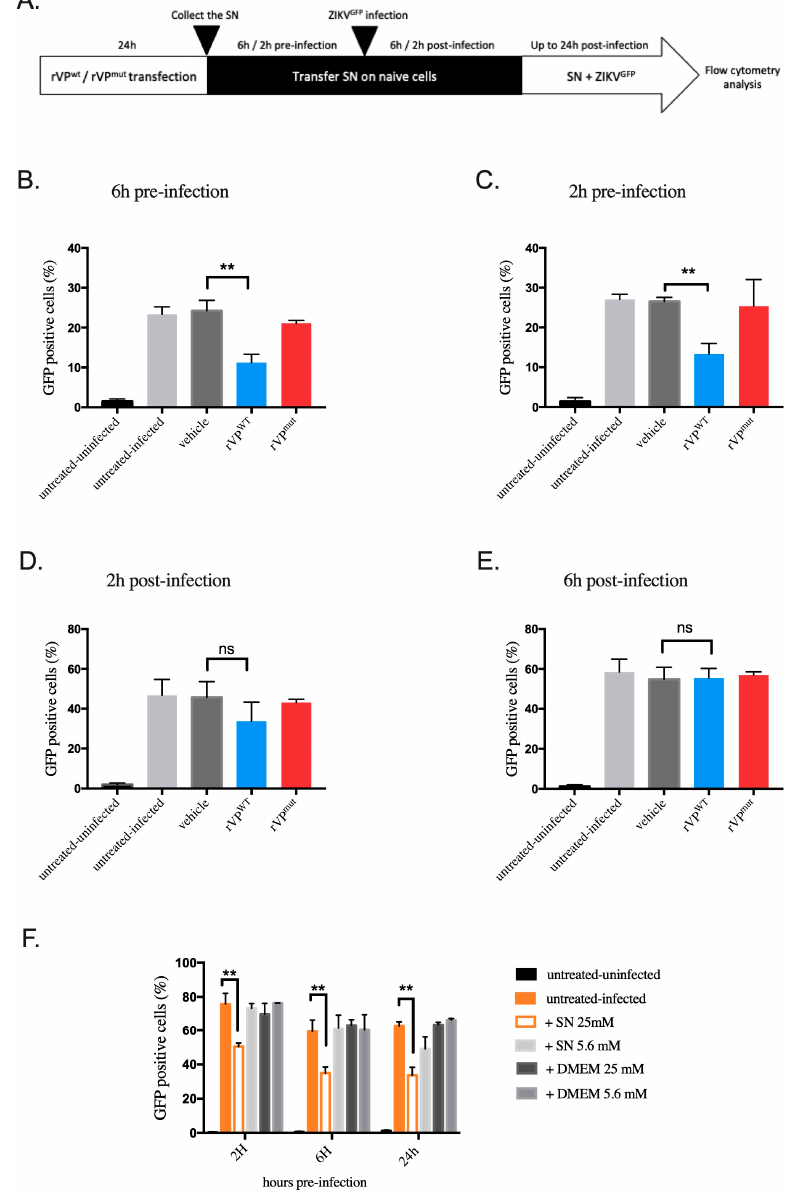
Figure 4. Paracrine inhibitory effect of supernatants from HK-2 cells overexpressing recombinant viperin (rVP) on ZIKV infection. ( A ) Experimental design to characterize the antiviral activity of cell supernatant (SN) from HK-2 transfected with rVP ( B – E ). The supernatants of HK-2 cells transfected with rVP wt or rVP mut were transferred onto naive HK-2 NGC cells at ( B ) 6 h pre-infection, ( C ) 2 h pre-infection, ( D ) 2 h post-infection, and ( E ) 6 h post-infection. ( F ) Supernatants of HK-2 HGC cells or a 72 h period were transferred on naive HK-2 NGC cells at 2 h, 6 h, and 24 h pre-infection. For all these conditions, cells were then infected with ZIKV GFP for 24 h followed by flow cytometry analysis. SN 5.6 mM: supernatant of HK-2 NGC cells; DMEM 25 mM: high glucose medium; DMEM 5.6 mM: low glucose medium. Data are representative of at least three independent experiments. Results are shown as means ± SD. Unpaired t-test and two-way ANOVA show that differences are either non-significant (ns) or statistically significant (** p <